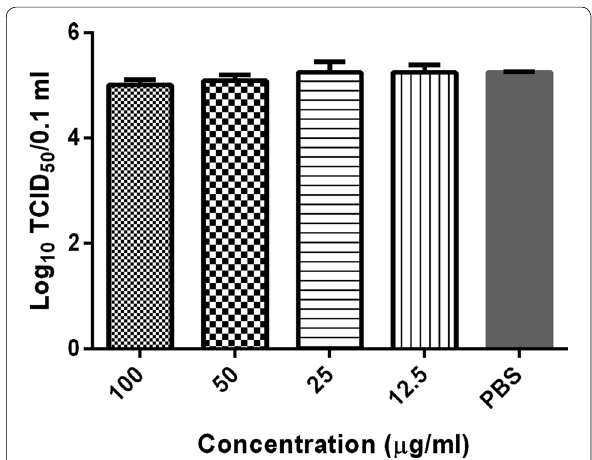
Fig. 7 Neutralization activity assessment of the S7 antibody. The neutralization effect of the S7 antibody on PEDV was analyzed in Vero cells. Different concentrations of S7 antibody were incubated with PEDV, and the TCID 50 was determined by the Reed Muench method. PBS was used as a negative